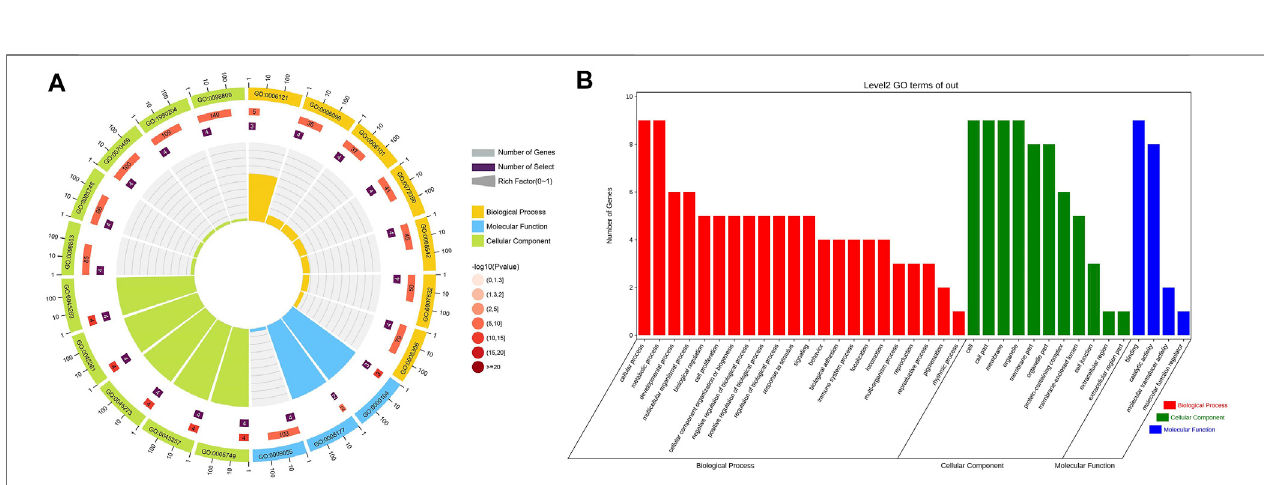
FIGURE 5 | GO functional classi fi cation results of nine genes related to GIST (A) Circle Diagram of GO Molecular Function Enrichment (B) Bar Chart of GO Molecular Function Enrichment.